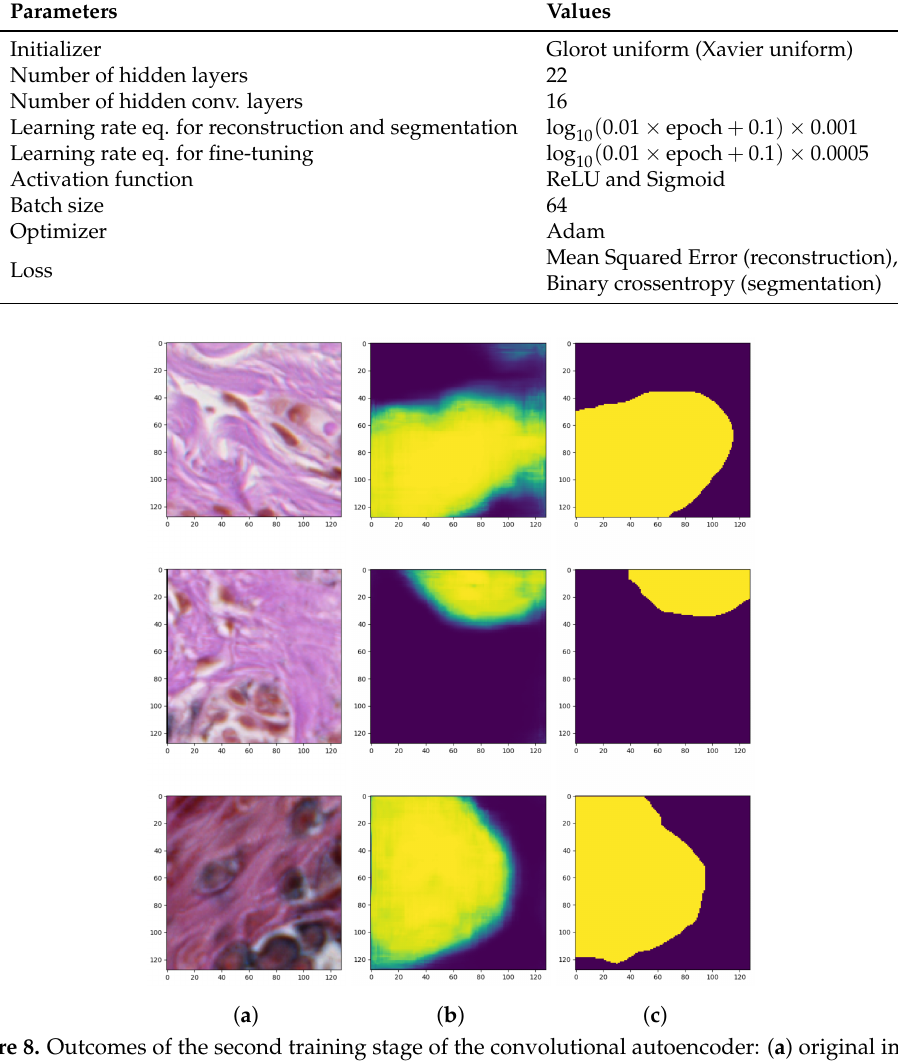
Figure 8. Outcomes of the second training stage of the convolutional autoencoder: ( a ) original images (patches), ( b ) generated masks, and ( c ) ground-truth